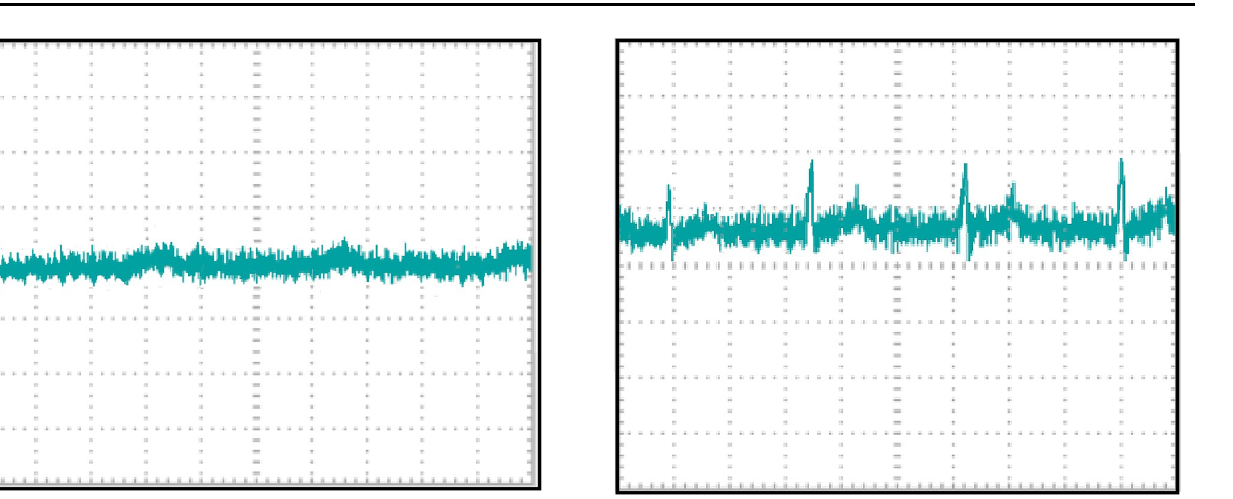
Fig. 12 ECG signal after instrumentational amplifier